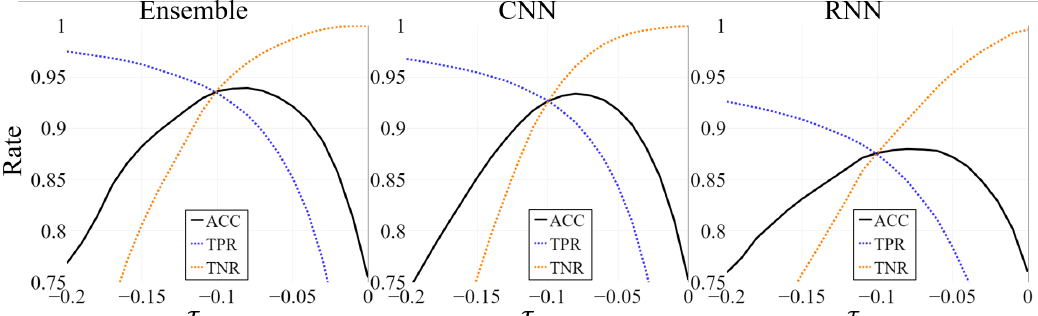
Figure 7. Performance as function of τ for fixed γ and ν . We set γ = 1.9 and ν = 0.06 for the ensemble model, γ = 1.8 and ν = 0.06 for the CNN model, and γ = 2.2 and ν = 0.08 for the RNN model.